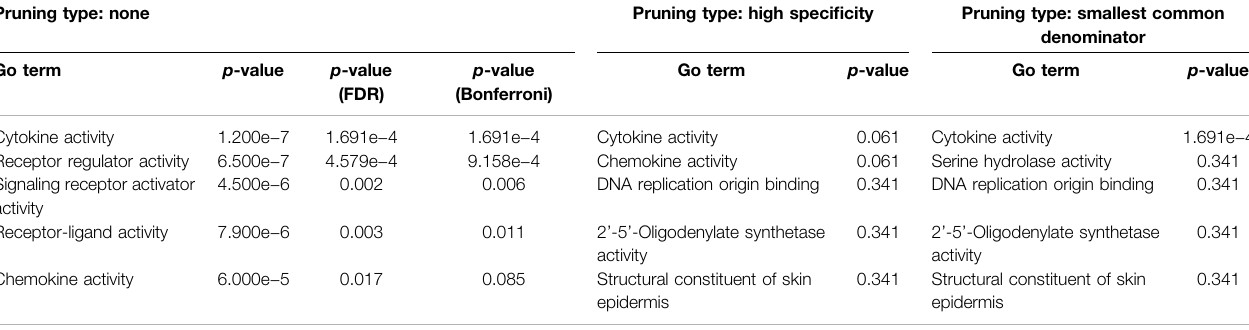
TABLE 4 | Top identi fi ed molecular functions for each pruning type.